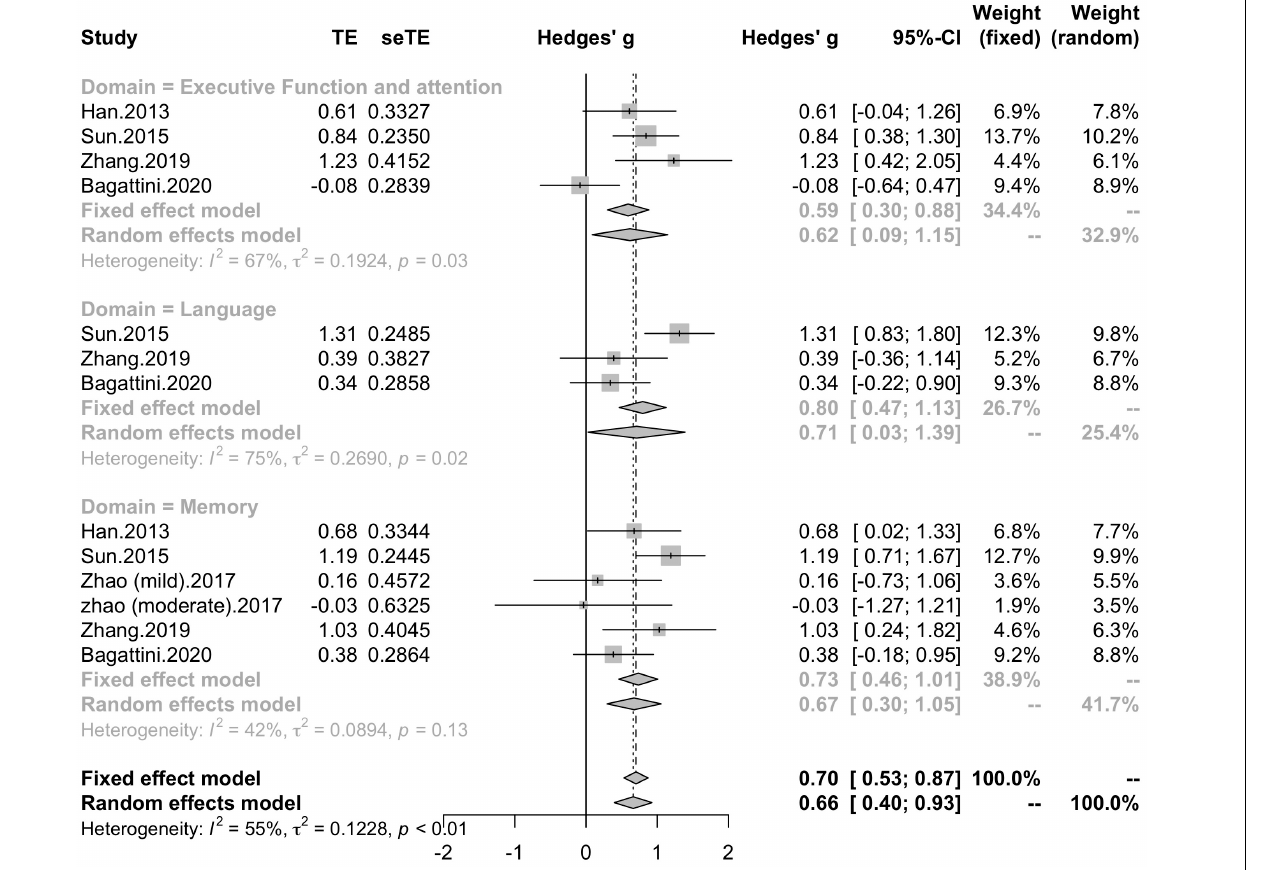
FIGURE 10 | Forest plot: mean difference in effect of rTMS on different cognitive domain in patients with MCI or early AD with 95%